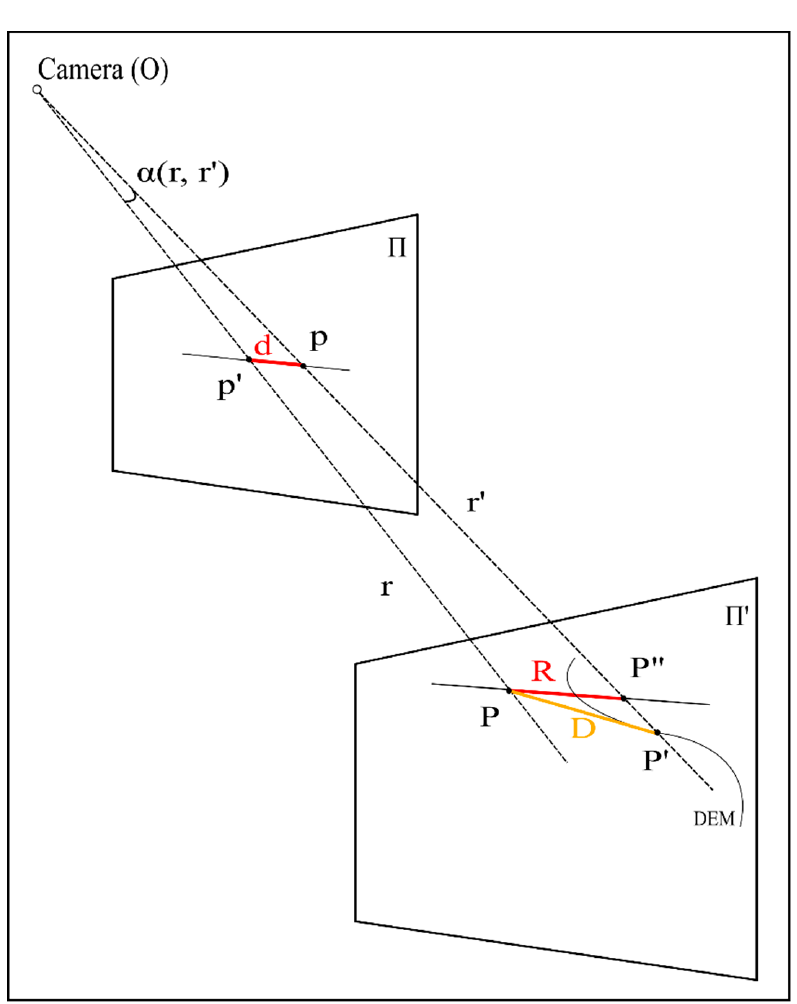
Figure 2. Visual representation of the camera calibration algorithm and derivation of error values used by MPT; figure adapted from [21,25]. The symbols are defined in the above paragraph and in Table 1.